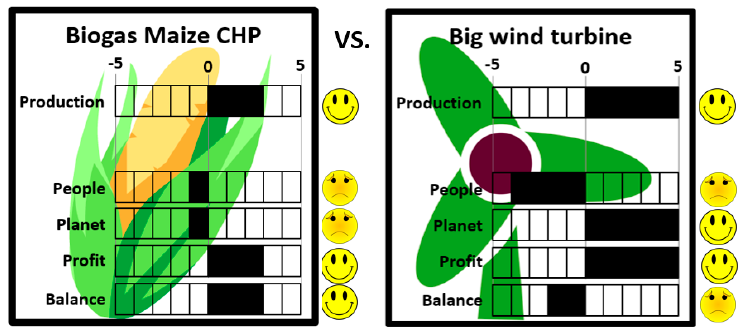
Figure 2. Scores for each role, depending on energy source.